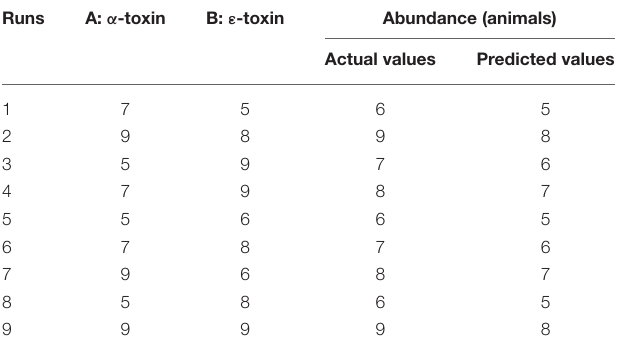
TABLE 5 | Actual and predicted values for the abundance of C. perfringens toxinotypes in four different zones of Punjab province in Pakistan. Runs